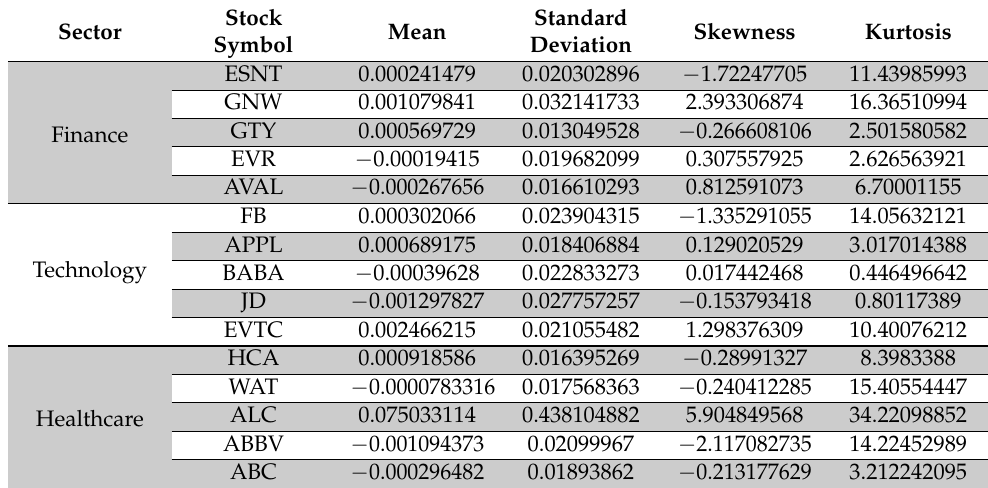
Table 6. Descriptive statistics of the daily rate of returns r t + 1 of the selected stocks.